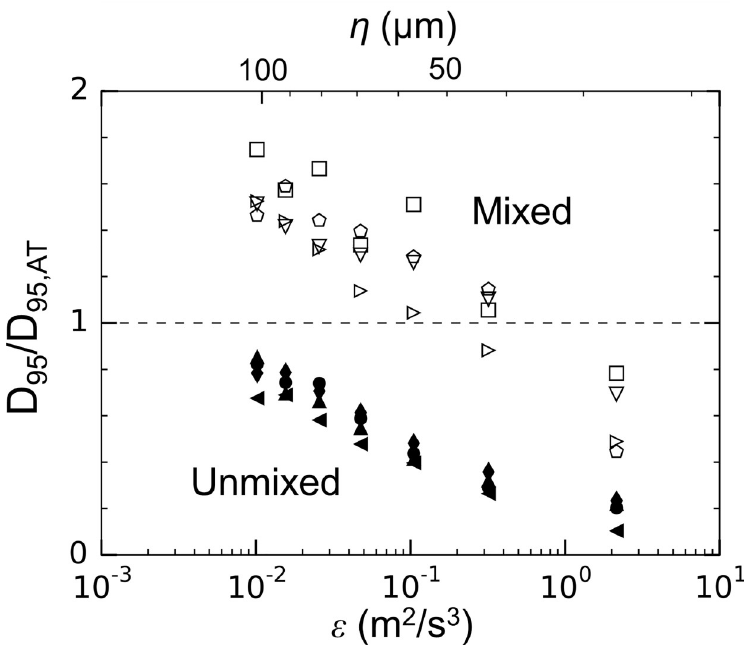
Fig 10. Change in largest floc size with turbulent dissipation rate in the siphon tubes. Symbols are consistent with Table 3.